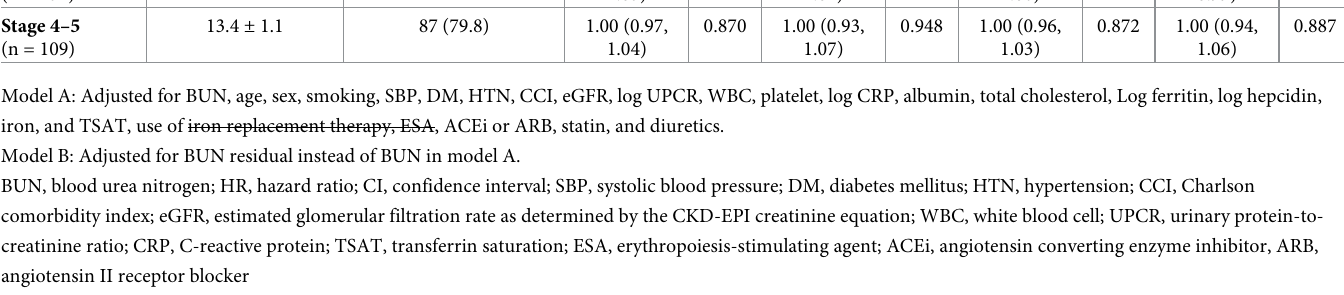
Table 5. Cox regression analysis of the relationship between BUN, BUN residual, eGFR, and anemia development according to the stages of CKD. CKD stage